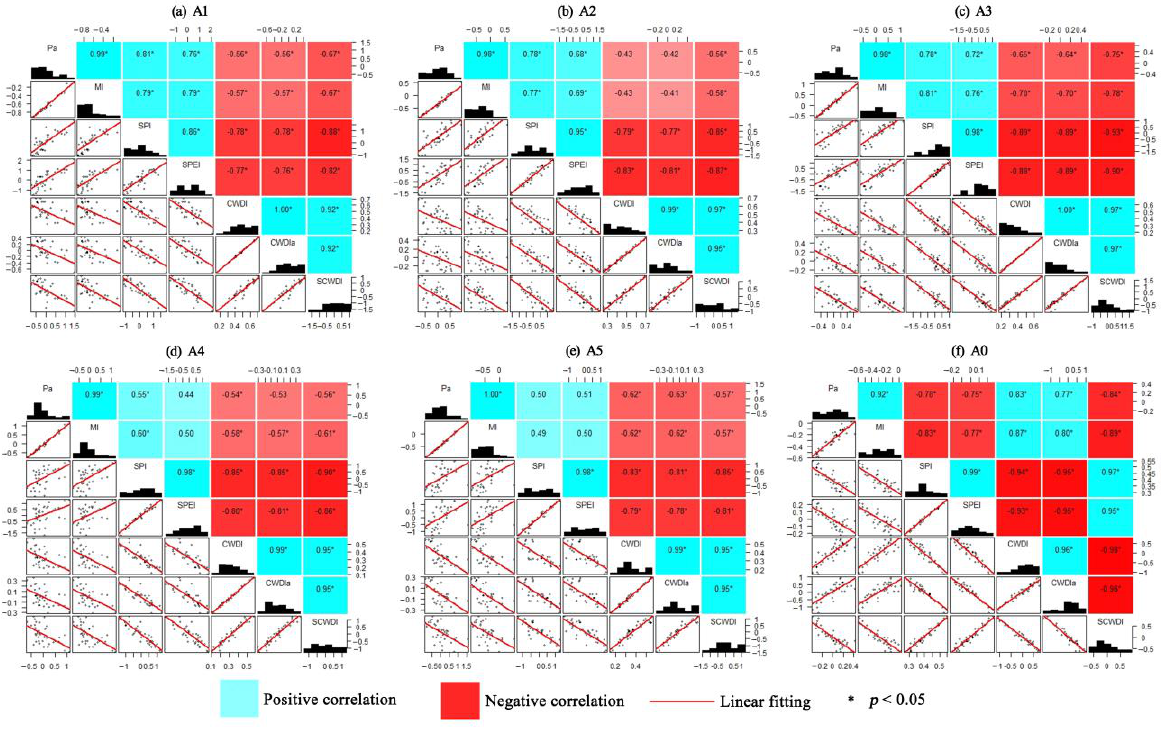
Figure 9. Correlation between SCWDI and the commonly used drought index in different growth stages of spring maize: ( a ) the sowing to seedling stage; ( b ) the seedling to jointing stage; ( c ) the jointing to heading stage; ( d ) the heading to milk mature stage; ( e ) the milk mature to mature stage; and ( f ) the whole growth